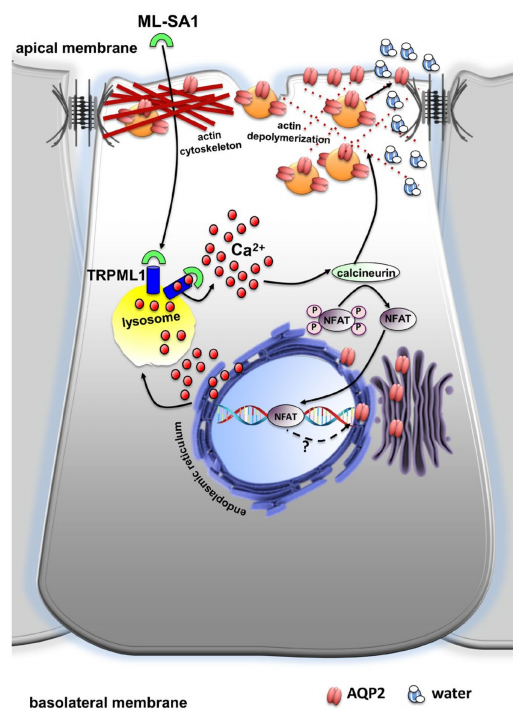
Figure 11. Proposed schematic diagram illustrating the effect of TRPML1 activation on AQP2- mediated water homeostasis in mouse renal collecting duct cells. ML-SA1 activates TRPML1 gen- erating Ca 2+ signaling events that are sustained by the endoplasmic reticulum Ca 2+ content. The subsequent activation of the Ca 2+ /calcineurin/NFAT pathway leads to depolymerization of the actin cytoskeleton, thereby facilitating AQP2 accumulation at the apical plasma membrane and increasing water permeability. The possible role of TRPML1-induced NFAT transcriptional activity on AQP2 expression needs further investigation (question